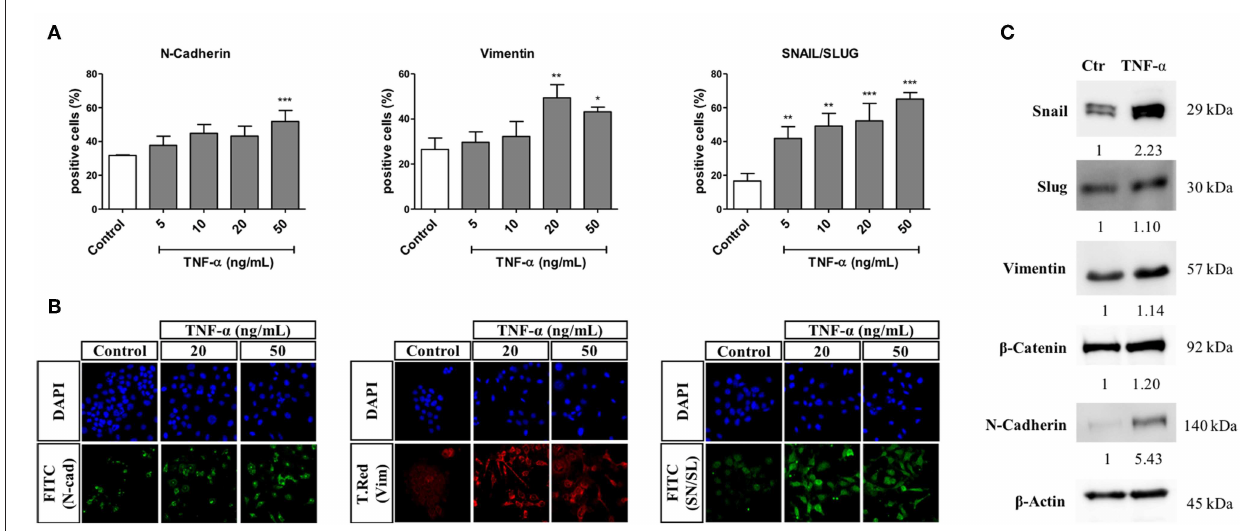
FIGURE 3 | Effects of TNF- α in the expression of EMT-related proteins. The FADU cell line was stimulated or not (Control) with TNF- α (5 to 50ng/mL), for 72h, followed by analyses of EMT-related protein levels by immunostaining or western blot. After immunostaining using antibodies against N-cadherin (N-cad), Vimentin (Vim) and Snail/Slug (SN/SL), cells were co-stained with nuclear (Hoechst) and cytoplasmic (CellMask) fluorescent dyes. Images (nine fields per well) were acquired using a 10X objective and excitation/emission filters DAPI (Hoechst), FITC (N-Cadherin and SN/SL), and Texas Red (T.Red; Vimentin), using an ImageXpress Micro XLS HCS system (Molecular Devices). Images were analyzed using MetaXpress, in order to evaluate the percentage of cells positive for each protein in the nucleus or cytoplasm. For western blot, protein detection was achieved using antibodies against Snail, Slug, Vimentin, beta-catenin and N-Cadherin. (A) Nuclear or cytoplasmic quantitative changes (Mean + -SD) in protein levels of N-Cadherin, Vimentin and Snail/Slug, as evaluated by immunofluorescence. (B) Representative images of stained cells stimulated with TNF- α at 20 and 50ng/mL. (C) Alterations (fold change) in the protein levels of Snail, Slug, Vimentin, beta-catenin and N-Cadherin, as evaluated by western blot after 72h of TNF- α stimulation (20ng/mL). Statistically significant differences (ONE-WAY Anova with Tukey post-test), in comparison to the control condition: * p < 0.05; ** p < 0.01; *** p <